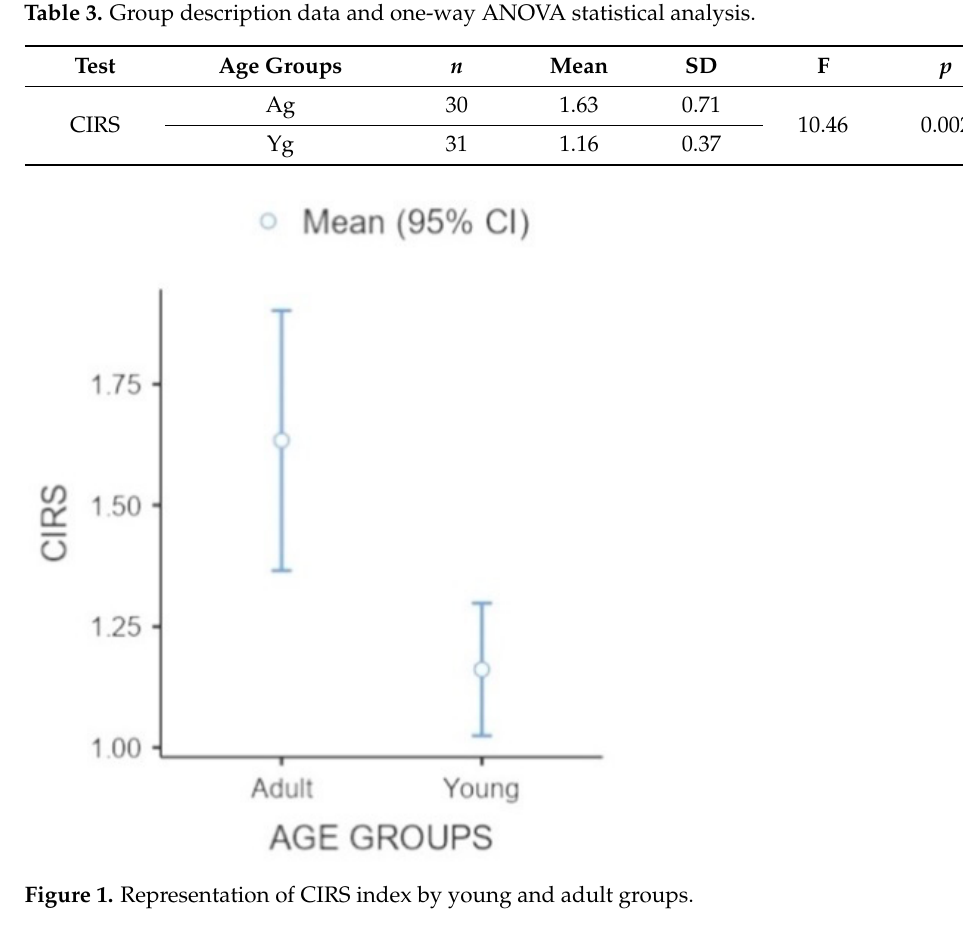
Table 3. Group description data and one-way ANOVA statistical analysis.